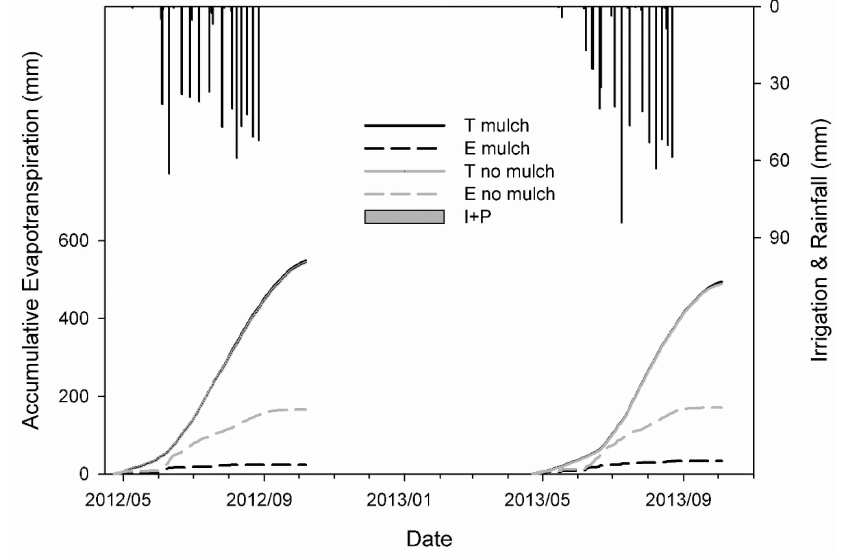
Figure 8. Evaporation and transpiration by the SIMDualKc during growing season for two years. T values under plastic mulch cover were 549.2 mm and 495.0 mm in 2012 and 2013, respectively, and 545.2 mm and 493.2 mm without mulch cover, respectively. No significant difference was